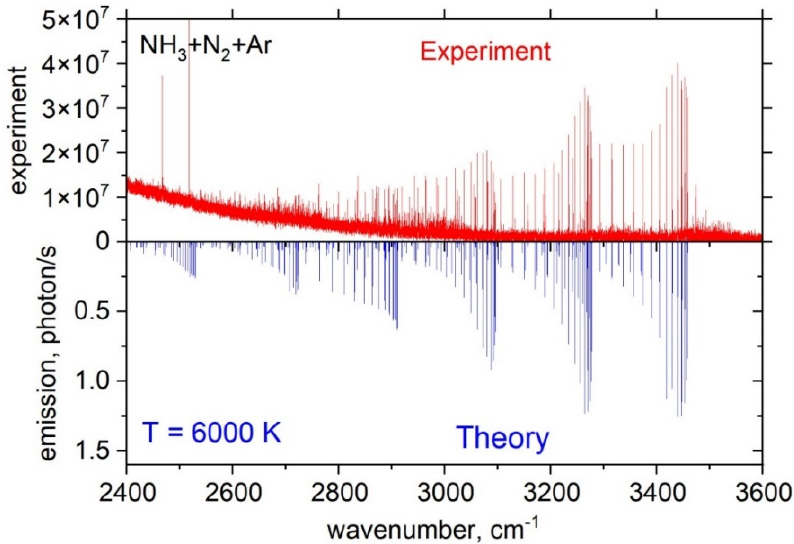
Figure 19. Experiment (red) versus theory (blue) modeling of the NH spectra between 2500 and 3500 cm − 1 obtained from the NH 3 + N 2 + Ar mixture. The theoretical spectrum corresponds to T V = 6000 K and T R = 500 K, the Lorentzian line profile and a HWHM = 0.05 cm − 1 . The MoLLIST [156,157] line list was used.